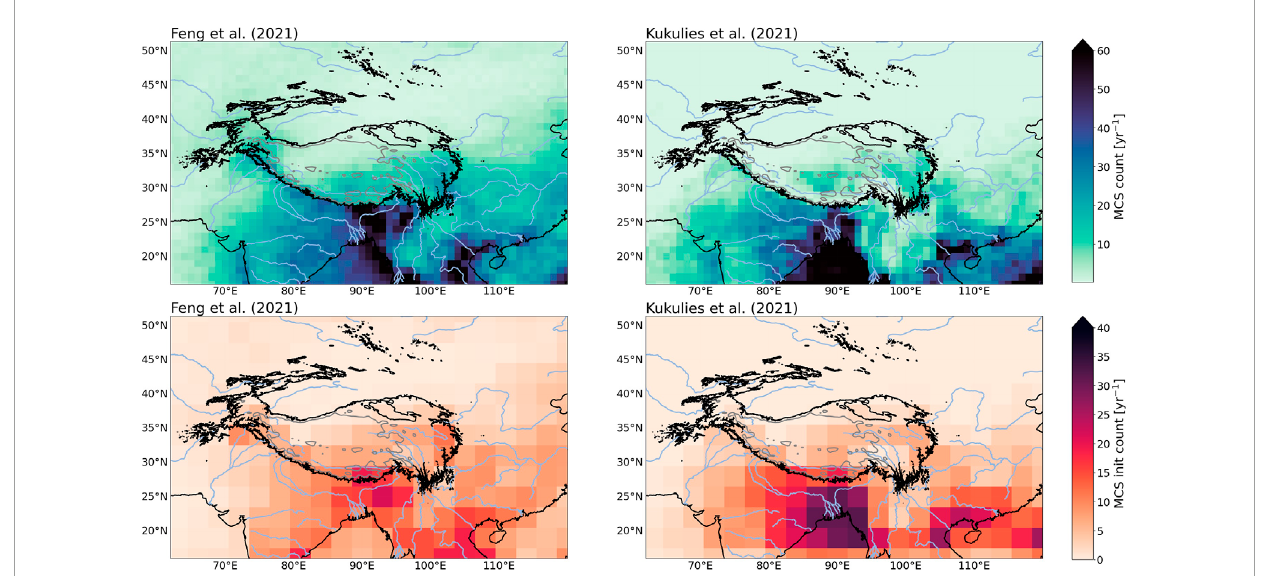
FIGURE 2 Spatial distribution of average MCS frequency throughout all lifecycle stages (upper panels) and MCS initiation frequency (lower panel) per year based on the datasets constructed by Kukulies et al. (2021); Feng et al. (2021a). The total number of MCSs has been computed based on their center locations on a 1x1 ° grid for every time step and for 1x1 ° on a 3x3 ° grid for the time steps of detection (initiation). The two MCS climatologies have been constructed independently, but based on the same infrared brightness temperatures from geostationary satellites combined with GPM IMERG v06 precipitation estimates. The black and gray contours show the 3000 m and 5,000 m elevation boundaries,